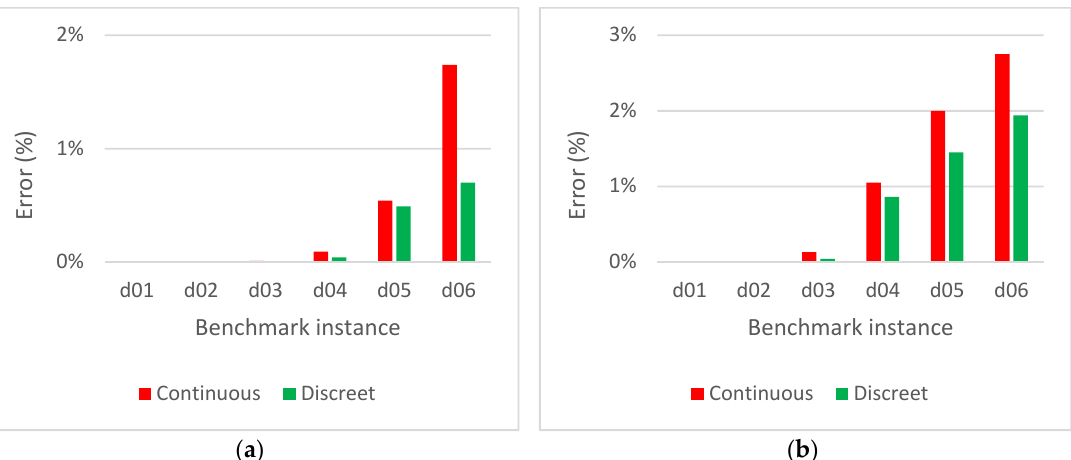
Figure 11. Comparison of the continuous and discrete versions of the algorithm: ( a ) error of the best solutions; ( b ) error of the average values.